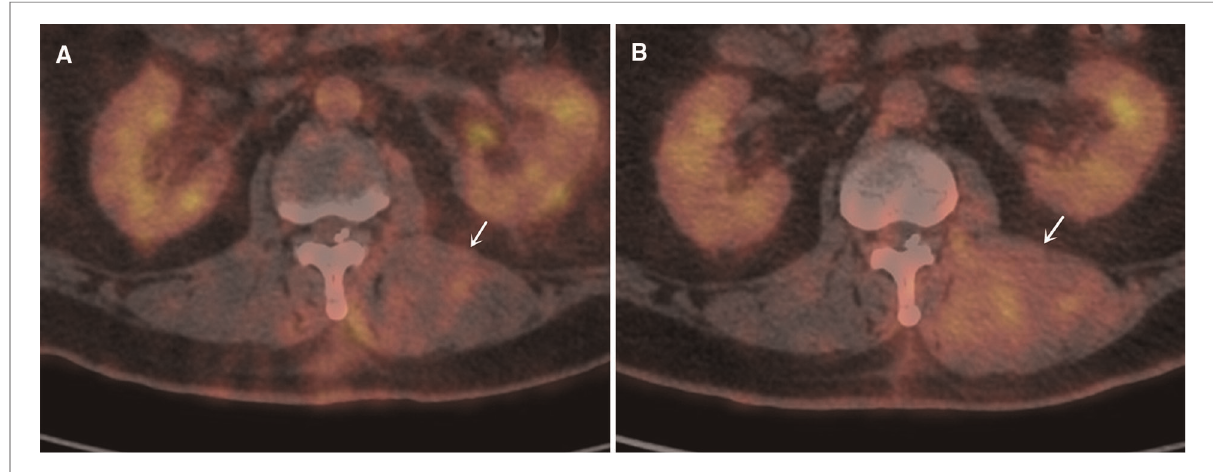
FIGURE 2 The images of paravertebral muscles on PET-CT at 3 and 6 months after surgery. ( A ) The image of paravertebral muscles on PET-CT at 3 months (white arrows indicates hypertrophic paravertebral muscles); ( B ) The image of paravertebral muscles on PET-CT at 6